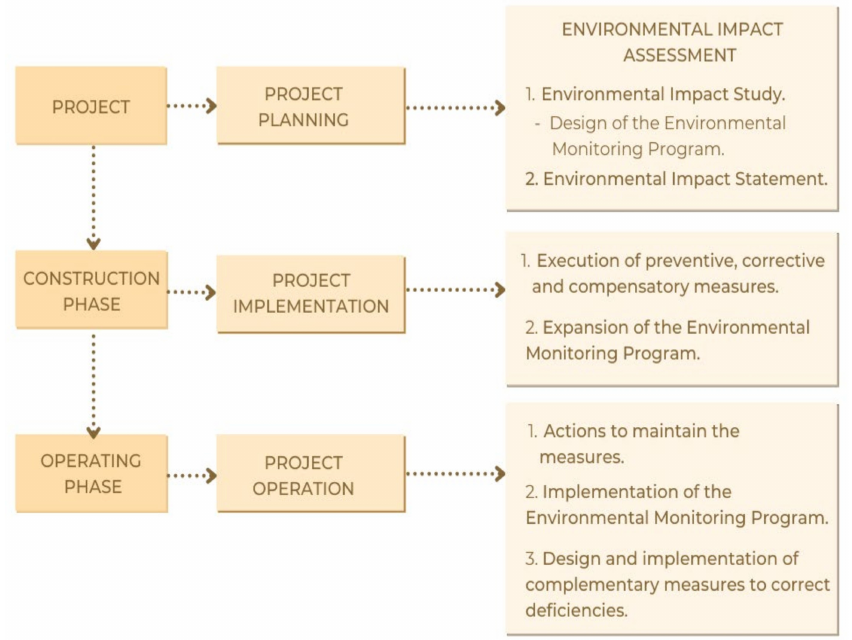
Figure 6. Project phases and procedures to mitigate the environmental impact. Adapted from